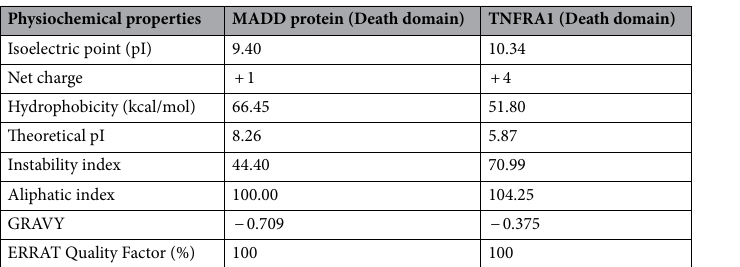
Table 1. Analysis of MADD and TNFR1 structures.